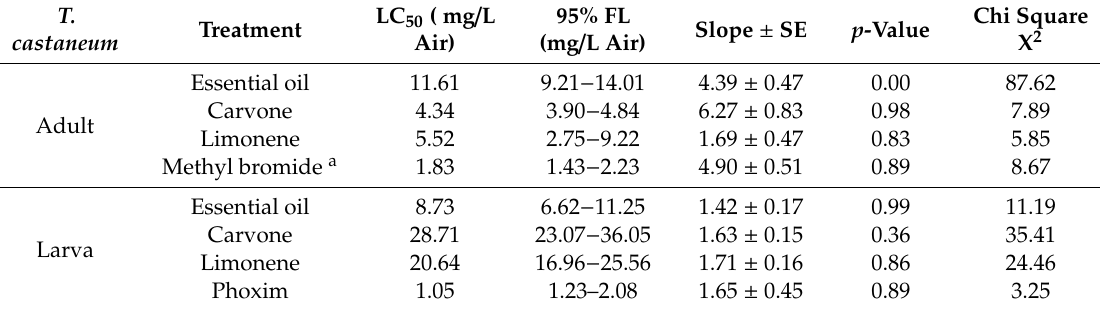
Table 3. Fumigant toxicity of E. ciliata essential oil and its main constituents against T. castaneum . T.